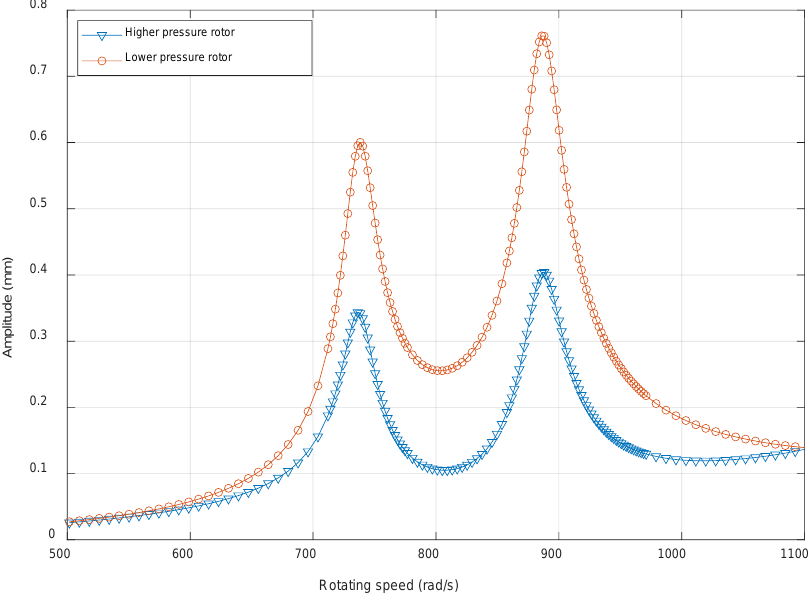
Figure 2. Deterministic steady-state responses of the dual-rotor system.